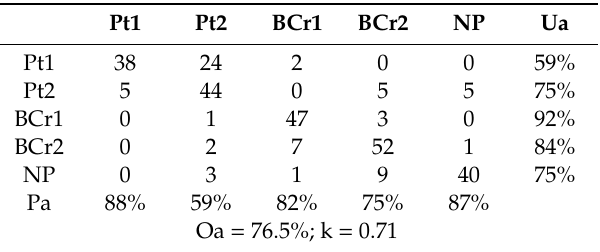
Table 3. Error matrix and associated OBIA classifier accuracy based on 289 stratified random